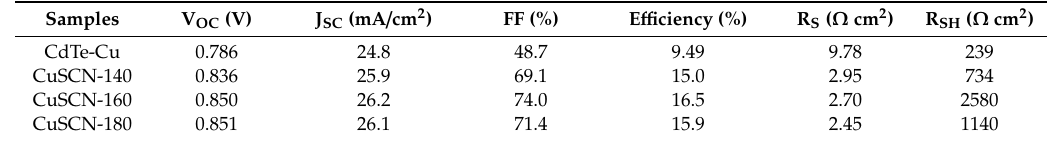
Figure 3. ( a ) Current density-voltage (J-V) and ( b ) external quantum efficiency (EQE) curves for the best devices with different back-contact treatment: evaporated Cu metal and spin-coated CuSCN with different annealing temperatures. Table 2. Device performance of the best cells in CdTe-Cu and CdTe-CuSCN, annealed at different temperatures.